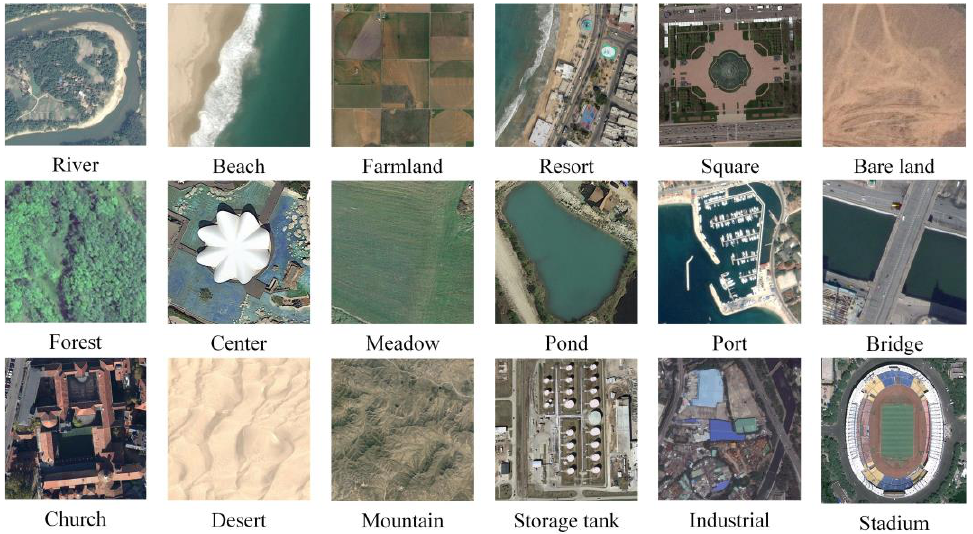
Figure 2. Several scene image samples in AID dataset.